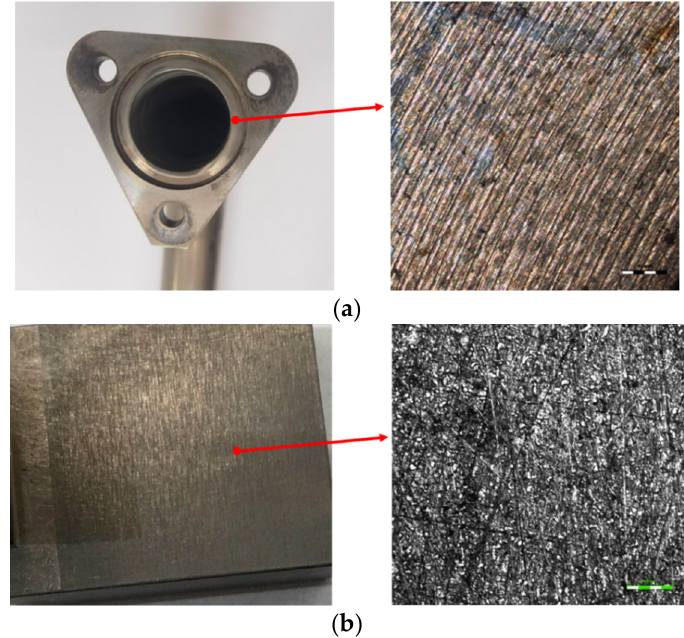
Figure 4. Examples of surface topography of the real surfaces: ( a ) turning; ( b )